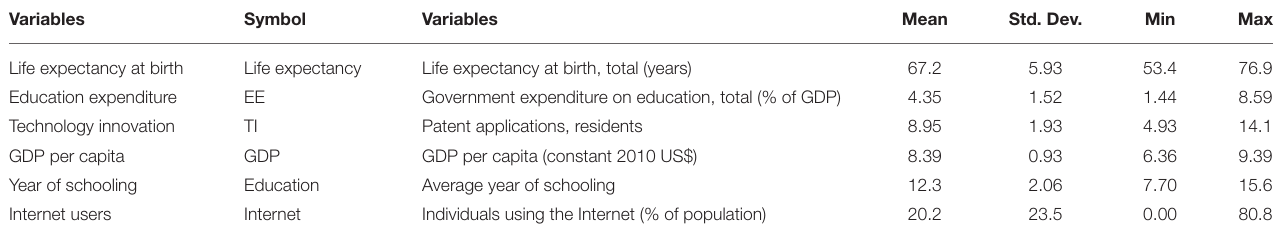
TABLE 1 | Variables definition and data descriptive.